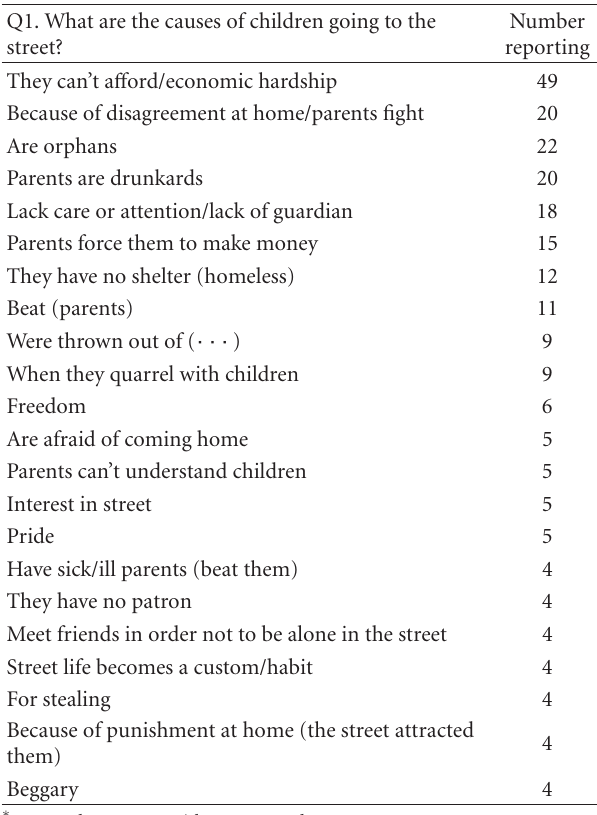
Georgian phrases given by respondents. Review and